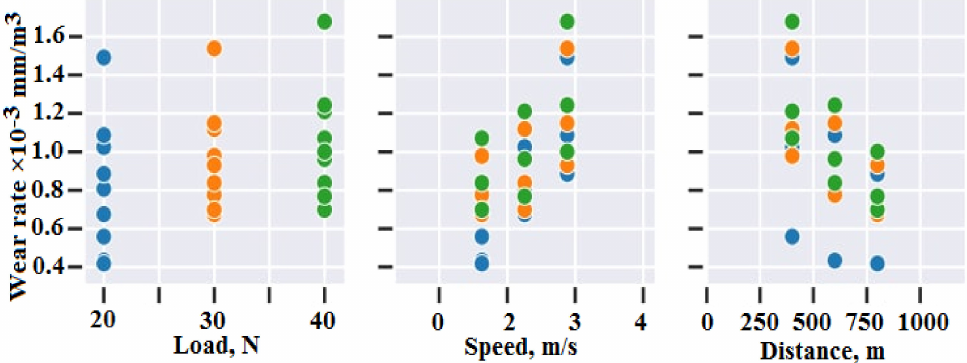
Figure 18. Interaction plot of sample A0, A1, and